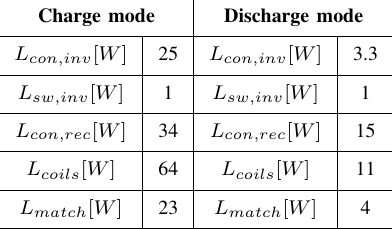
TABLE II C OMPUTED LOSSES